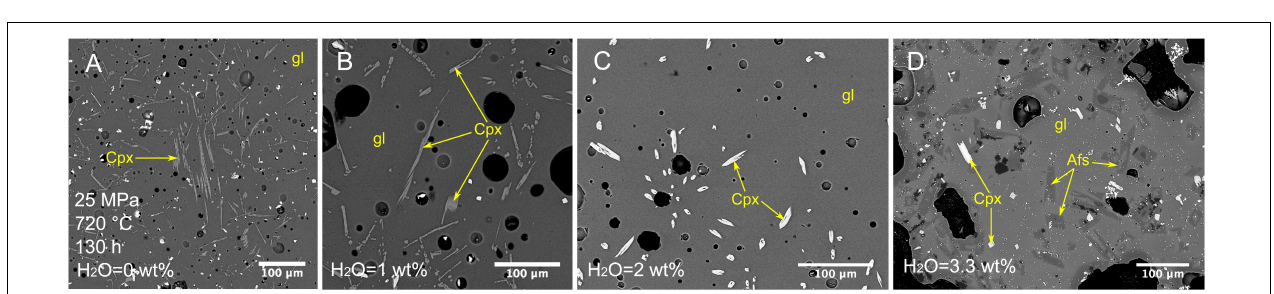
FIGURE 5 | Backscattered SEM images of textures obtained from isobaric cooling experiments at 25 MPa, 720 ◦ C and experimental duration of 130 h. (A) Sample C63: experiment at anhydrous condition. (B) Sample C65: experiment under water-undersaturated condition H 2 O = 1 wt.%. (C) Sample C133: experiment under water-undersaturated condition H 2 O = 2 wt.%. (D) Sample C151: experiment under water-saturated condition H 2 O = 3.3 wt.%. Afs, alkali feldspar; Cpx, clinopyroxene; gl,